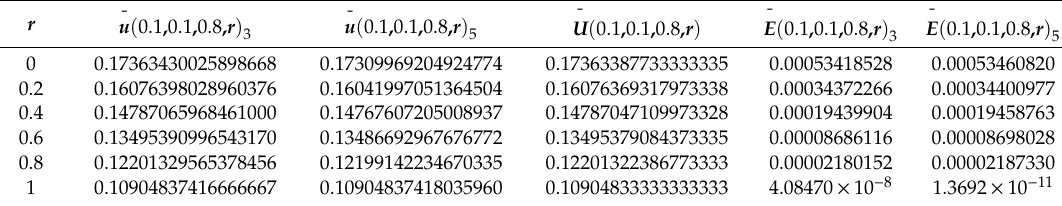
Table 5. Solution and accuracy of third and fifth order double parametric fuzzy HPM solutions for Equation (24) at t , x = 0.1 and b = 0.8 for all r ∈ [ 0,1 ]